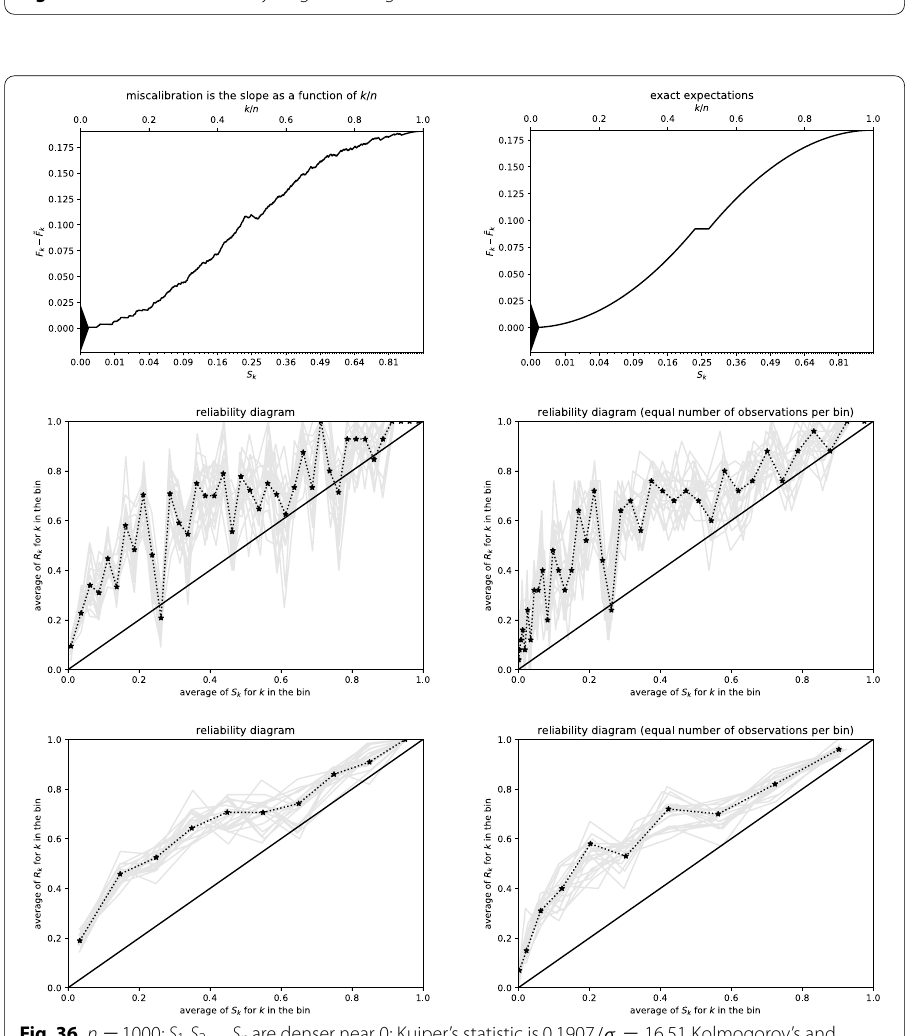
Fig. 36 n = 1000; S 1 , S 2 , ..., S n are denser near 0; Kuiper’s statistic is 0.1907 /σ = 16.51 , Kolmogorov’s and Smirnov’s is 0.1907 /σ = 16.51 . Figure 37 displays the ground-truth reliability diagram. As in Figure 34, all plots work sufficiently well, though the observed reliability diagrams may be misleading relative to the exact expectations, at least without careful attention to the variation with the number of